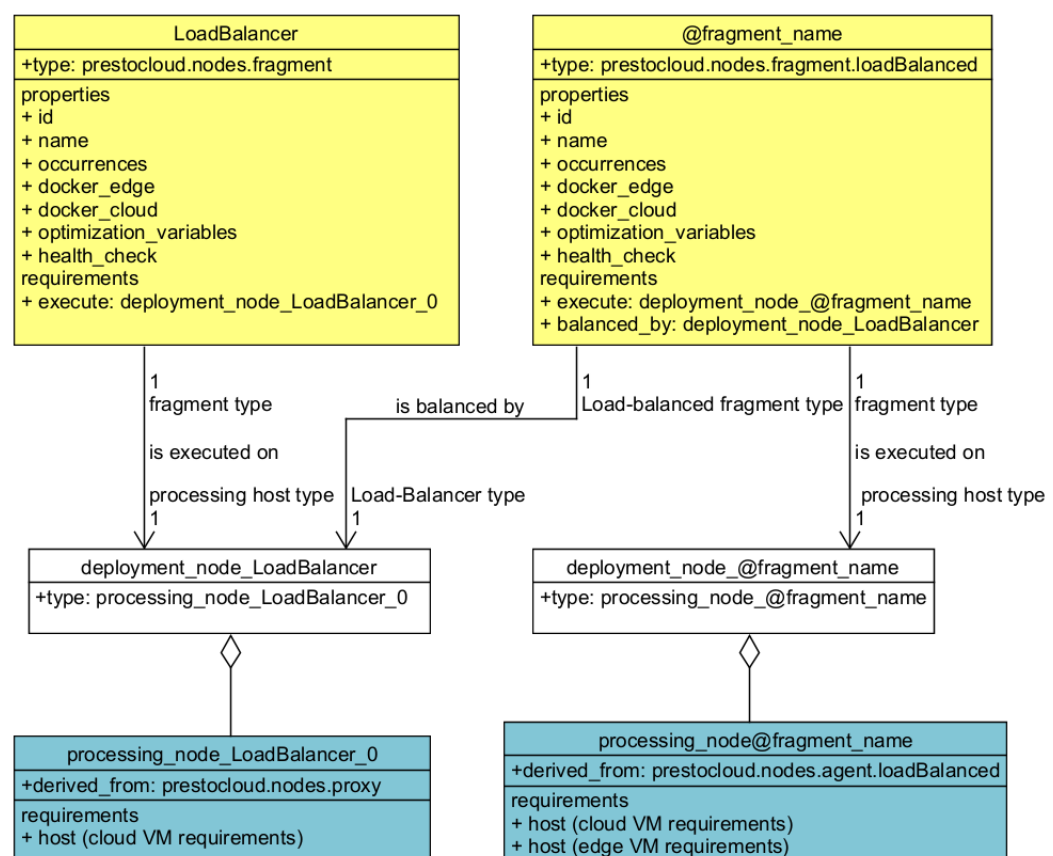
Figure 5. The relationships between the fragment, processing, and mapping nodes of the Load-Balancer and the balanced fragments.